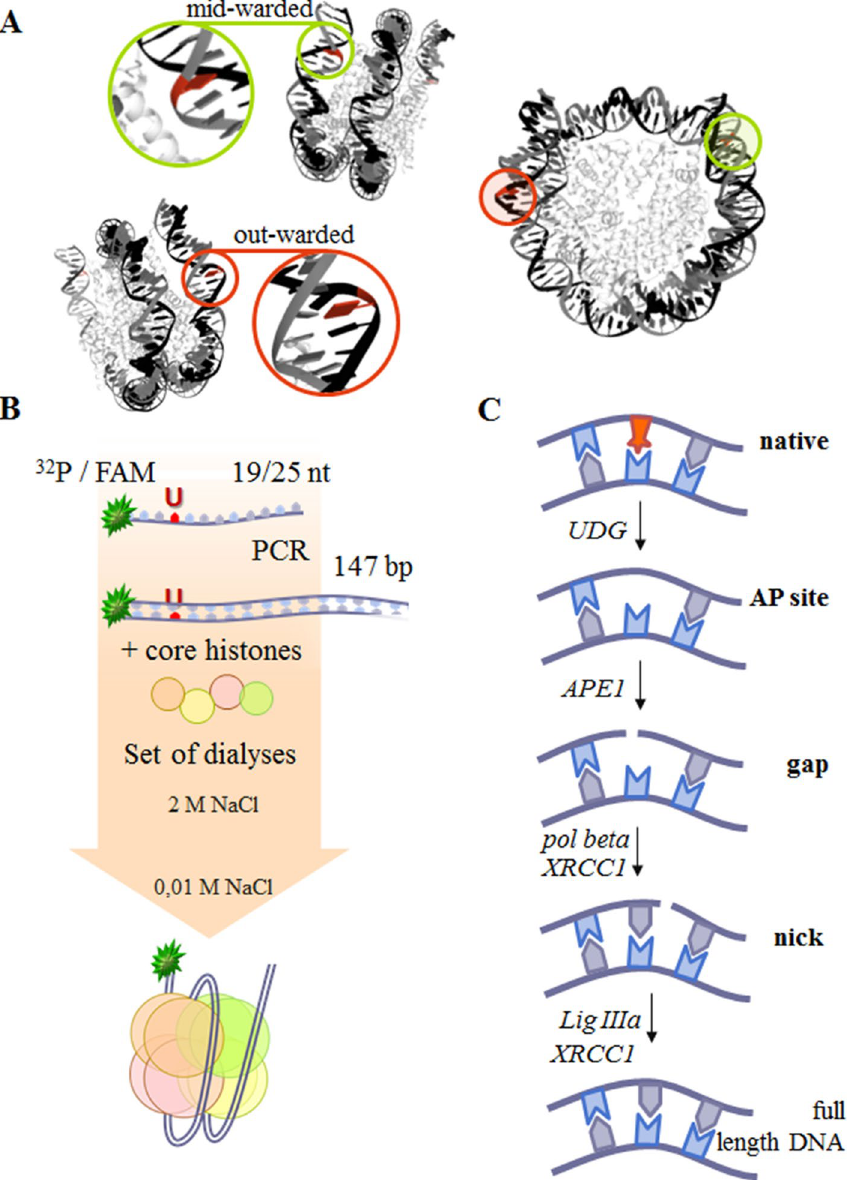
Figure 1. ( A ) Nucleosome structure pictured according to Ref. 86 and was created using RCSB PDB online version specifically https ://www.rcsb.org/struc ture/3LZ0. The red nucleobases depict the positions of midward- or outward-oriented lesions. ( B ) The scheme of preparation of different types of NCPs. The coloured line corresponds to the DNA strand, whereas the green asterisk to the 5 ′ [ 32 P] or FAM label. ( C ) Stages of BER with the participating enzymes and substrates tested in this